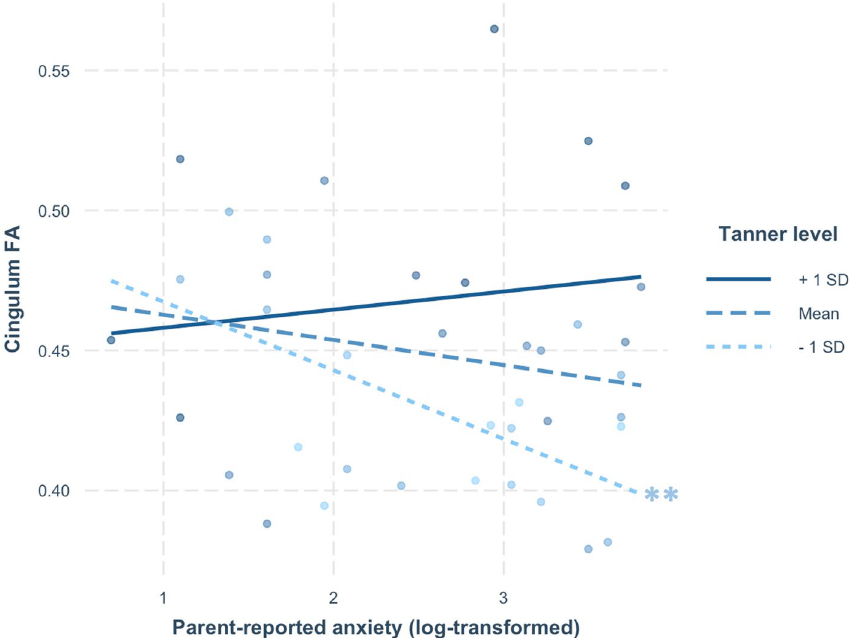
Figure 2. Pubertal stage moderates the association between anxiety symptoms and cingulum FA. Simple slopes tested the association between anxiety symptoms and cingulum FA at Tanner levels of 1.14 (− 1 SD), 1.94 (0 SD), and 2.73 (+ 1 SD). Anxiety symptoms predicted reduced cingulum FA for children in early pubertal stages (− 1 SD). ** p <